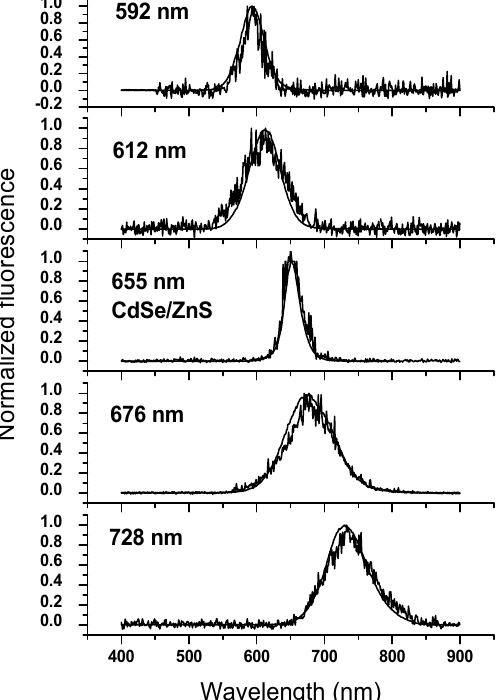
Figure 1. Short- (smooth, steady-state fluorescence) and long-lived (non-smooth, time-resolved luminescence) luminescence emission spectra of CdTe NPs of different size (emission maximum at 592, 615, 676 and 728 nm) and commercial CdSe/ZnS NPs (emission maximum at 655 nm) as recorded in